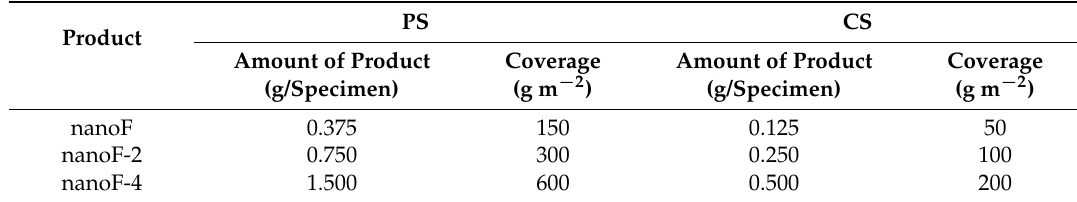
Table 2. Nomenclature of the treated samples and details of the